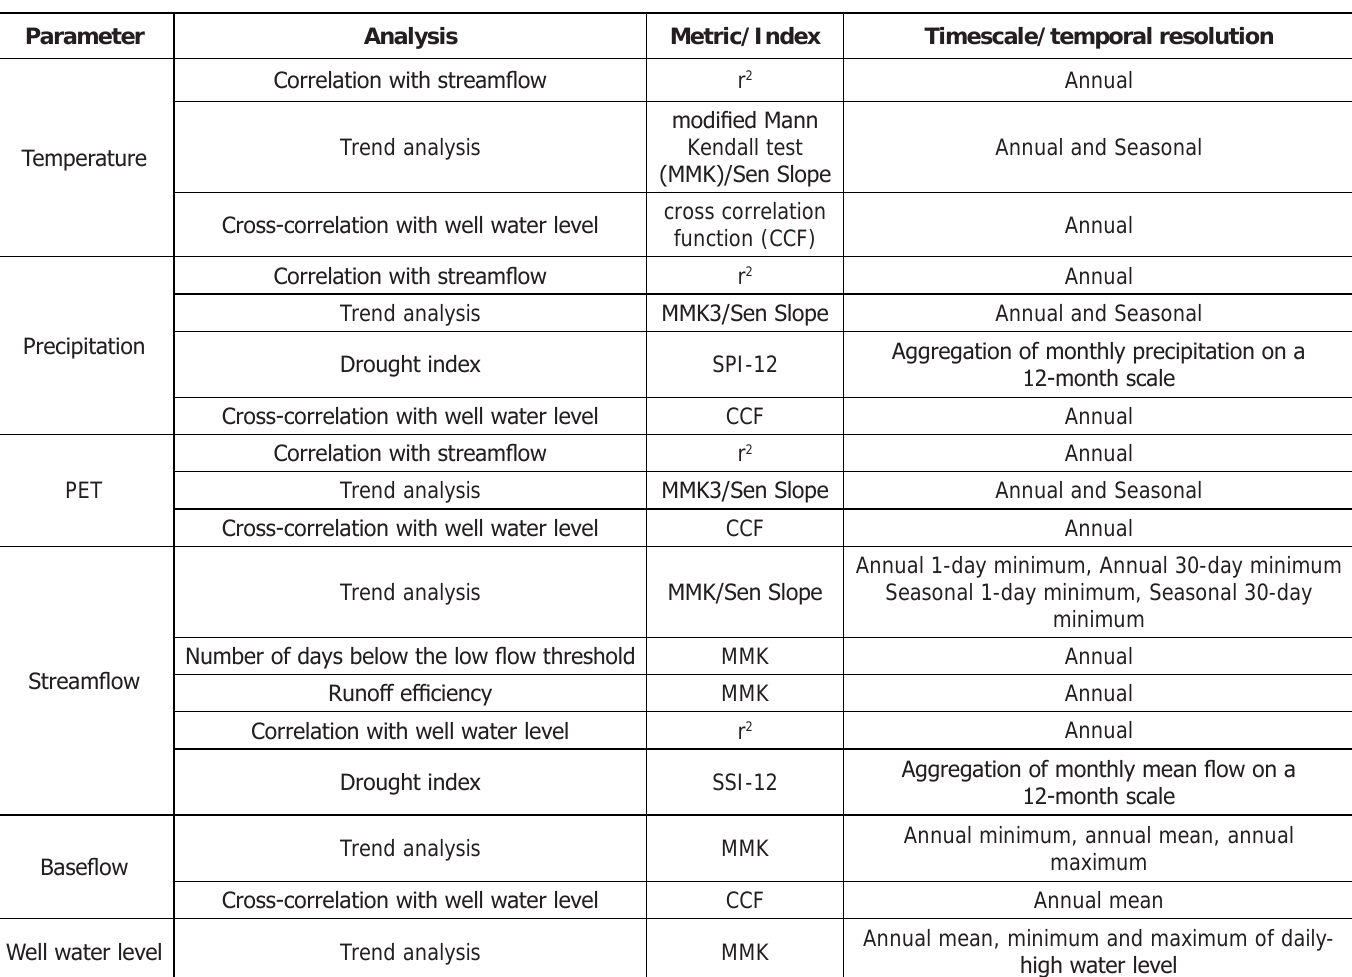
Table S2. Time scale for various metrices and indices